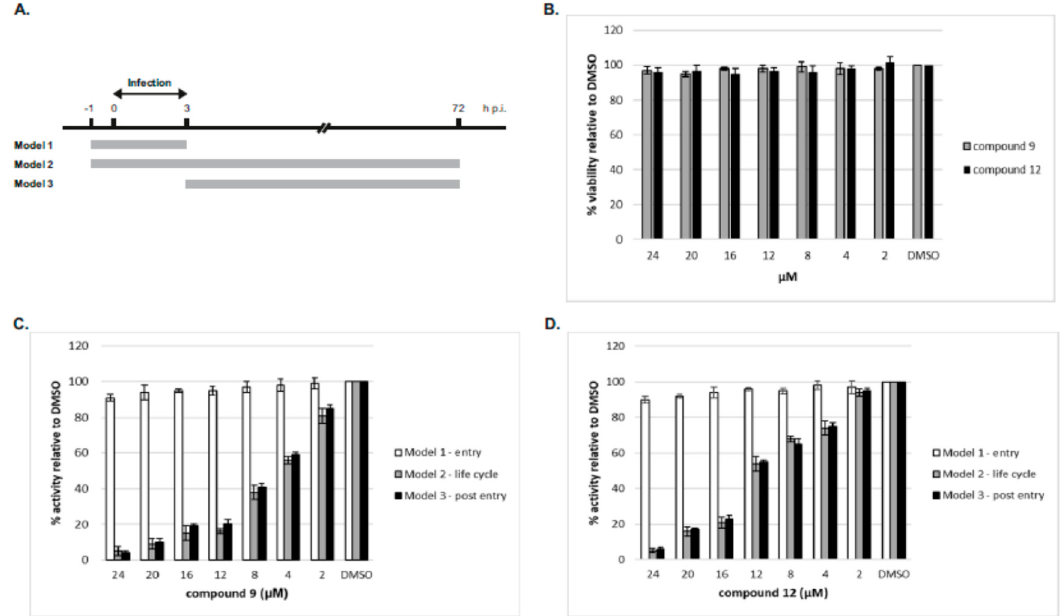
Figure 3. Antiviral activity of compounds 9 and 12 on hepatitis C virus (HCV) infection. ( A ) Schematic representation of infection models. ( B ) The viability analysis of Huh7-J20 cells treated for 72 h with various concentrations of compounds 9 and 12 with no viral infection. The values of compound-treated cells are expressed as percentage relative to DMSO-treated cells expressed as 100% (control). ( C , D ) Huh7-J20 cells were pre-treated for 1 h and infected with cell-culture-infectious HCV (HCVcc) in the presence of various doses of 9 ( C ), 12 ( D ), or DMSO as a control for 3 h. Then, the inoculum was removed, and fresh medium without compound was added for 72 h (Model 1, white bars). Huh7-J20 cells were pre-treated for 1 h; infected with HCVcc for 3 h in the presence of various doses of 9 ( C ), 12 ( D ), or DMSO; and then incubated for 72 h with fresh medium including inhibitor or DMSO (Model 2, grey bars). Huh7-J20 cells were infected for 3 h with HCVcc and then treated with various doses of 9 ( C ), 12 ( D ), or DMSO for 72 h (Model 3, black bars). The inhibitory effects were determined by a secreted alkaline phosphatase (SEAP) assay performed on infected cell medium. Errors bars represent the S.D. of the means for three replicates.